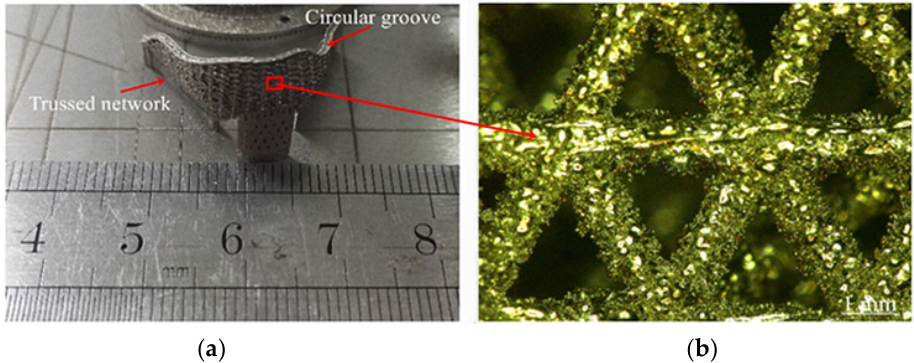
Figure 9. Thyroid cartilage prosthesis made by SLM: ( a ) SLM formed parts; ( b ) microstructure.